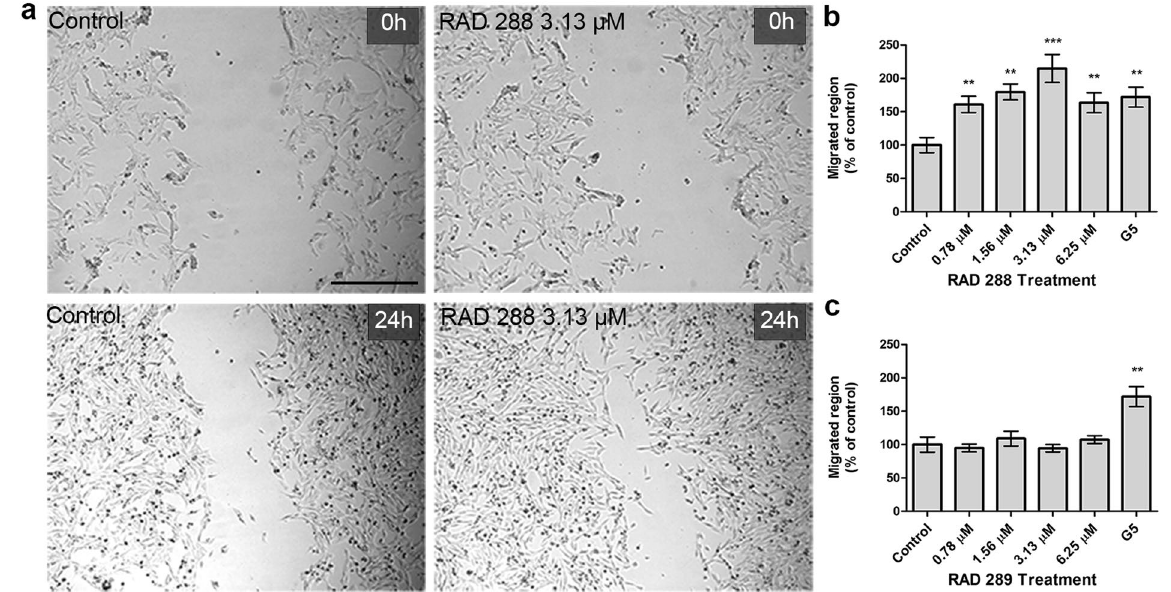
Figure 6. RAD288 enhances cell migration of mOECs in vitro . ( a ) Cell migration was detected using wound scratch assay. Representative wound closure images after drug exposure. Scale bar = 500 µ m. ( b ) Migrated region after treatments with different concentrations of RAD288 expressed as the percentage of control. ( c ) Migrated region after treatments with different concentrations of RAD289 expressed as the percentage of control. Values are presented as means ± SEM of five independent